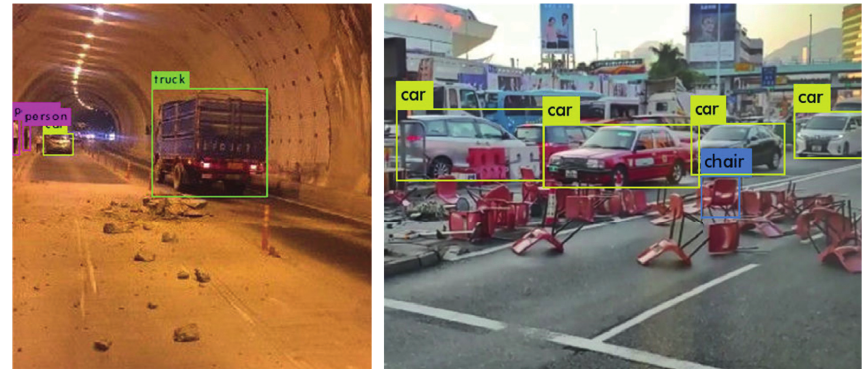
Figure 1: The results of obstacle identification based on faster RCNN.